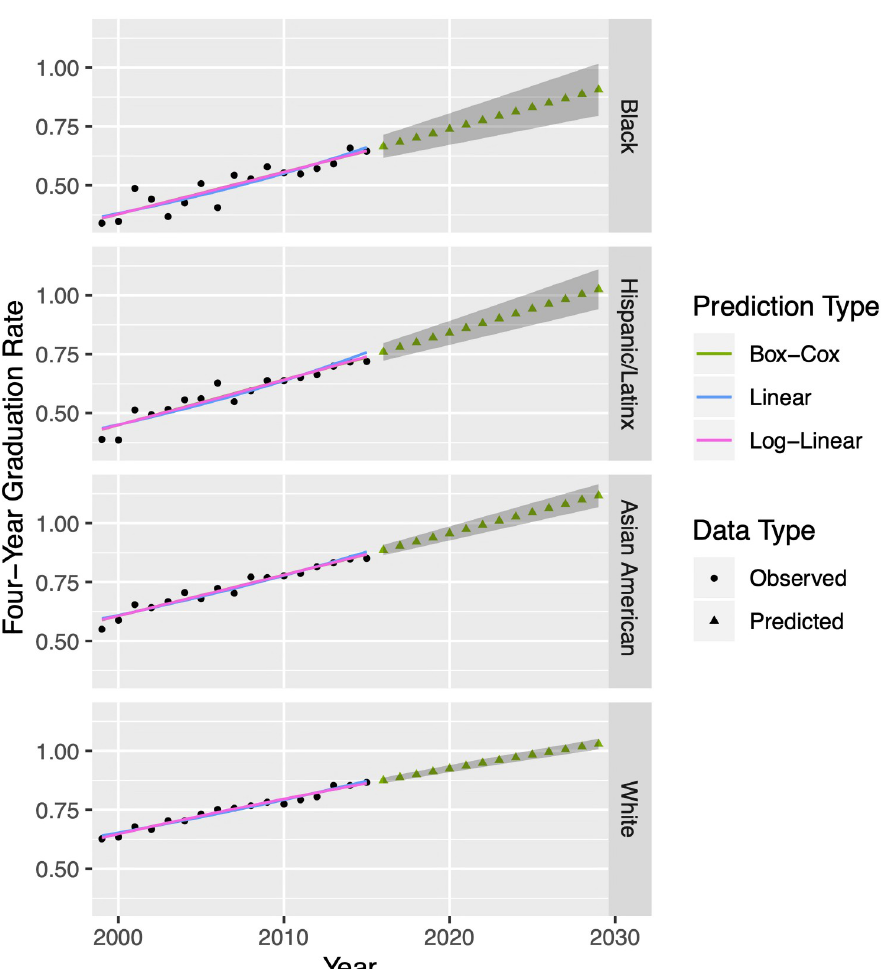
Fig 4. Regression models for four-year graduation rates at University of California-Berkeley. To model four-year graduation rates in each of four racial/ethnic groups from 1998—2015 (black dots) we apply three potential regression models, namely optimal Box-Cox (green), linear (blue) and log-linear (pink) to observed data from the University of California system [11]. We perform a standard residual analysis on each model in order to choose the best one. For the parameters depicted above, the best model happens to be Box-Cox for each. Table 2 provides our chosen fits. Using our chosen models, we forecast data from 2016—2029 (triangles). The 95% confidence intervals on predicted values appear as gray bands. We will use these intervals later to generate 95% confidence intervals on the output of our Markov chain model. While the figure above shows fits for four-year graduation rates, we follow a similar procedure for five-year and six-year graduation rates, as well as first-year retention rates; see Table 2. Note: if there is no optimal Λ for the Box-Cox transformation, the regression procedure defaults to linear. Hence, the linear and Box-Cox models sometimes